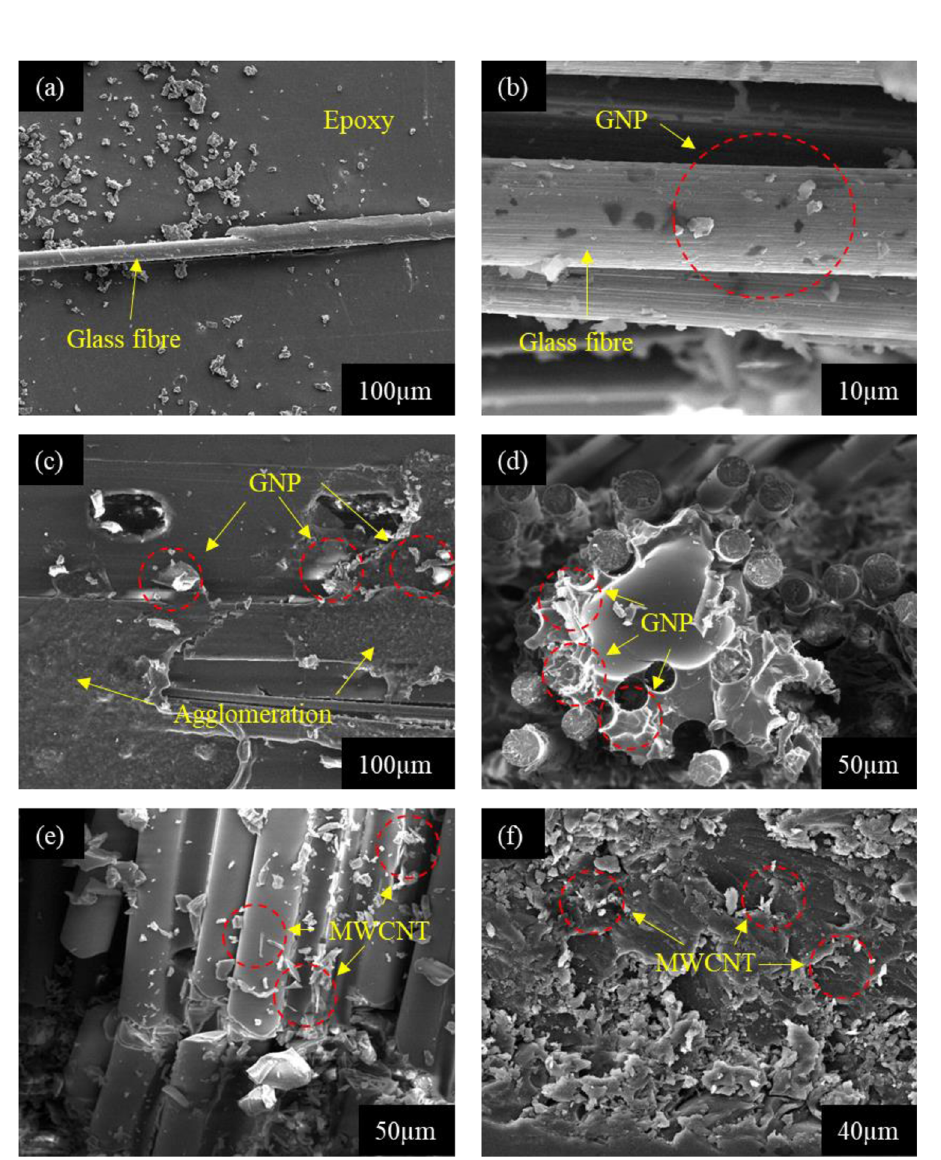
Figure 8: FESEM images: ( a ) fracture surface of glass, ( b ) – ( d ) GNP - glass, and ( e ) – ( f ) MWCNT - glass